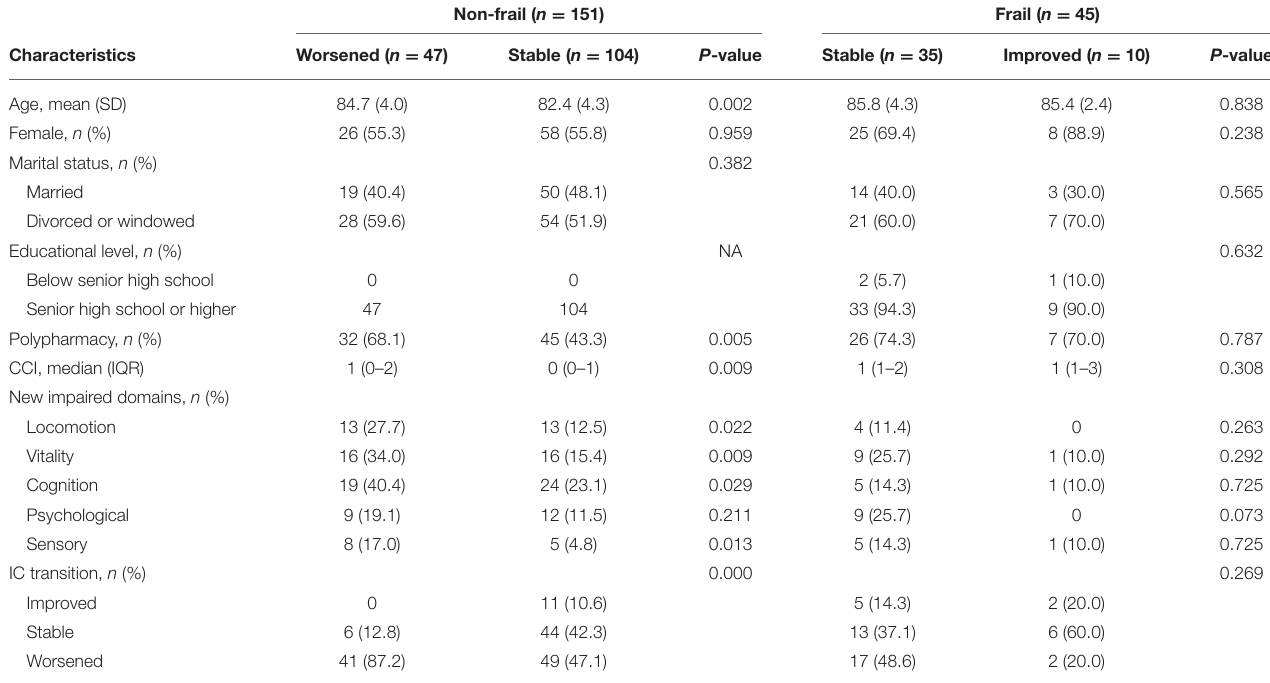
TABLE 2 | Comparison of characteristics among non-frail and frail participants according to frailty status transitions in a Beijing elderly community. Non-frail ( n = 151)